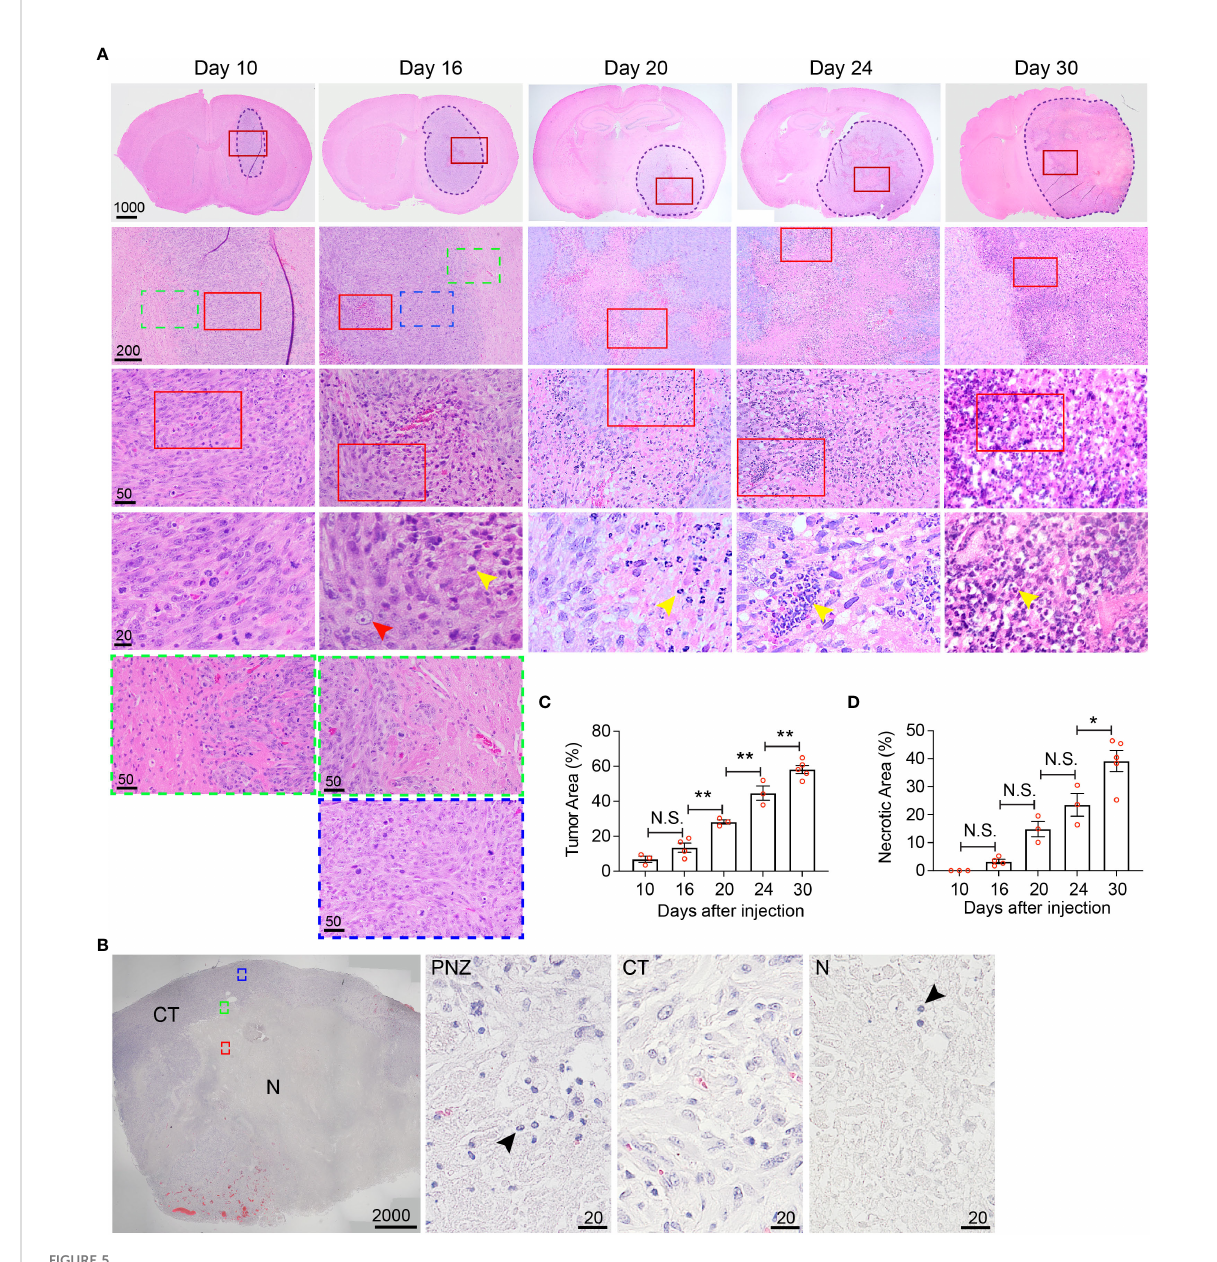
FIGURE 5 Histological characterization of the temporal development of GBM tumor necrosis. (A) Temporal development of GBM tumor necrosis from early to late tumor progression using representative time-course H&E-stained formaldehyde- fi xed paraf fi n embedded sections of LN229TAZ(4SA) brain tumor-bearing mice. Each column represents images acquired from the same animal at a certain tumor progression stage. In each section, the tumor stroma has been traced out using a dashed line. Areas marked by red rectangles were further magni fi ed in the images in the bottom of each column. For day 10 and 16 tumors, the areas marked by green (tumor border) or blue (cellular tumor) rectangles were also magni fi ed and shown in the bottom of the correspondent columns. Yellow arrowheads: small, round, dark purple nuclei, likely representing mouse immune cells; red arrowheads: large, light purple nuclei, representing LN229 human tumor cells. (B) Representative image of a H&E-stained formaldehyde- fi xed paraf fi n-embedded human GBM brain section showing cellular and necrotic tumor areas. The areas marked by green (peri-necrotic zone, PNZ), blue (cellular tumor, CT), or red (necrotic area, N) rectangles were magni fi ed and shown on right. Arrowheads: small, round, dark purple nuclei, likely representing immune cells. Specimens from three different patients (n=3) were examined independently with similar observations. (C) Quanti fi cation of tumor area normalized to whole brain area at each timepoint indicated in panel (A) . p ANOVA < 0.0001. Results of post hoc test for each continuous time point are indicated. (D) Quanti fi cation of necrotic areas, appearing as pale pink, acellular regions, normalized to corresponding tumor area at each timepoint indicated above p ANOVA < 0.0001. Results of post hoc test for each continuous time point are indicated. Tumors from three to fi ve tumor-bearing mice were sectioned and imaged in parallel as replicates with consistent observations (n=3-5); each datapoint shown in the bar graphs represents an animal. Scale bar is in µm. Ordinary one-way ANOVA. Sidak ’ s multiple comparisons test was used in the post hoc test. All center values shown are mean values, and all error bars represent standard errors of the mean (s.e.m). N.S., p > 0.05. *,p < 0.05; **,p <